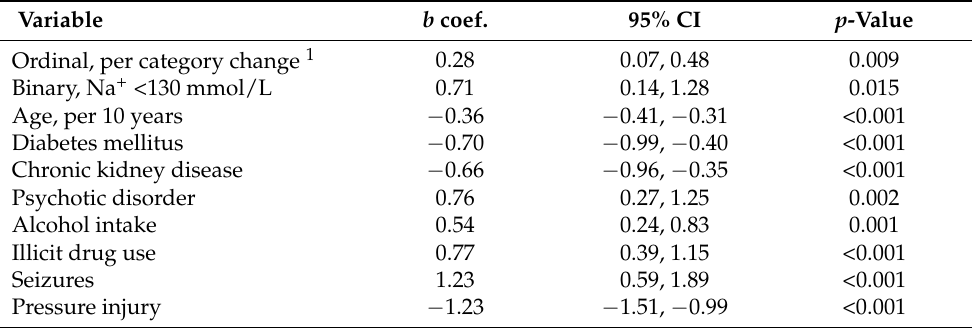
Table 5. Univariable regression analysis of log creatine kinase on independent